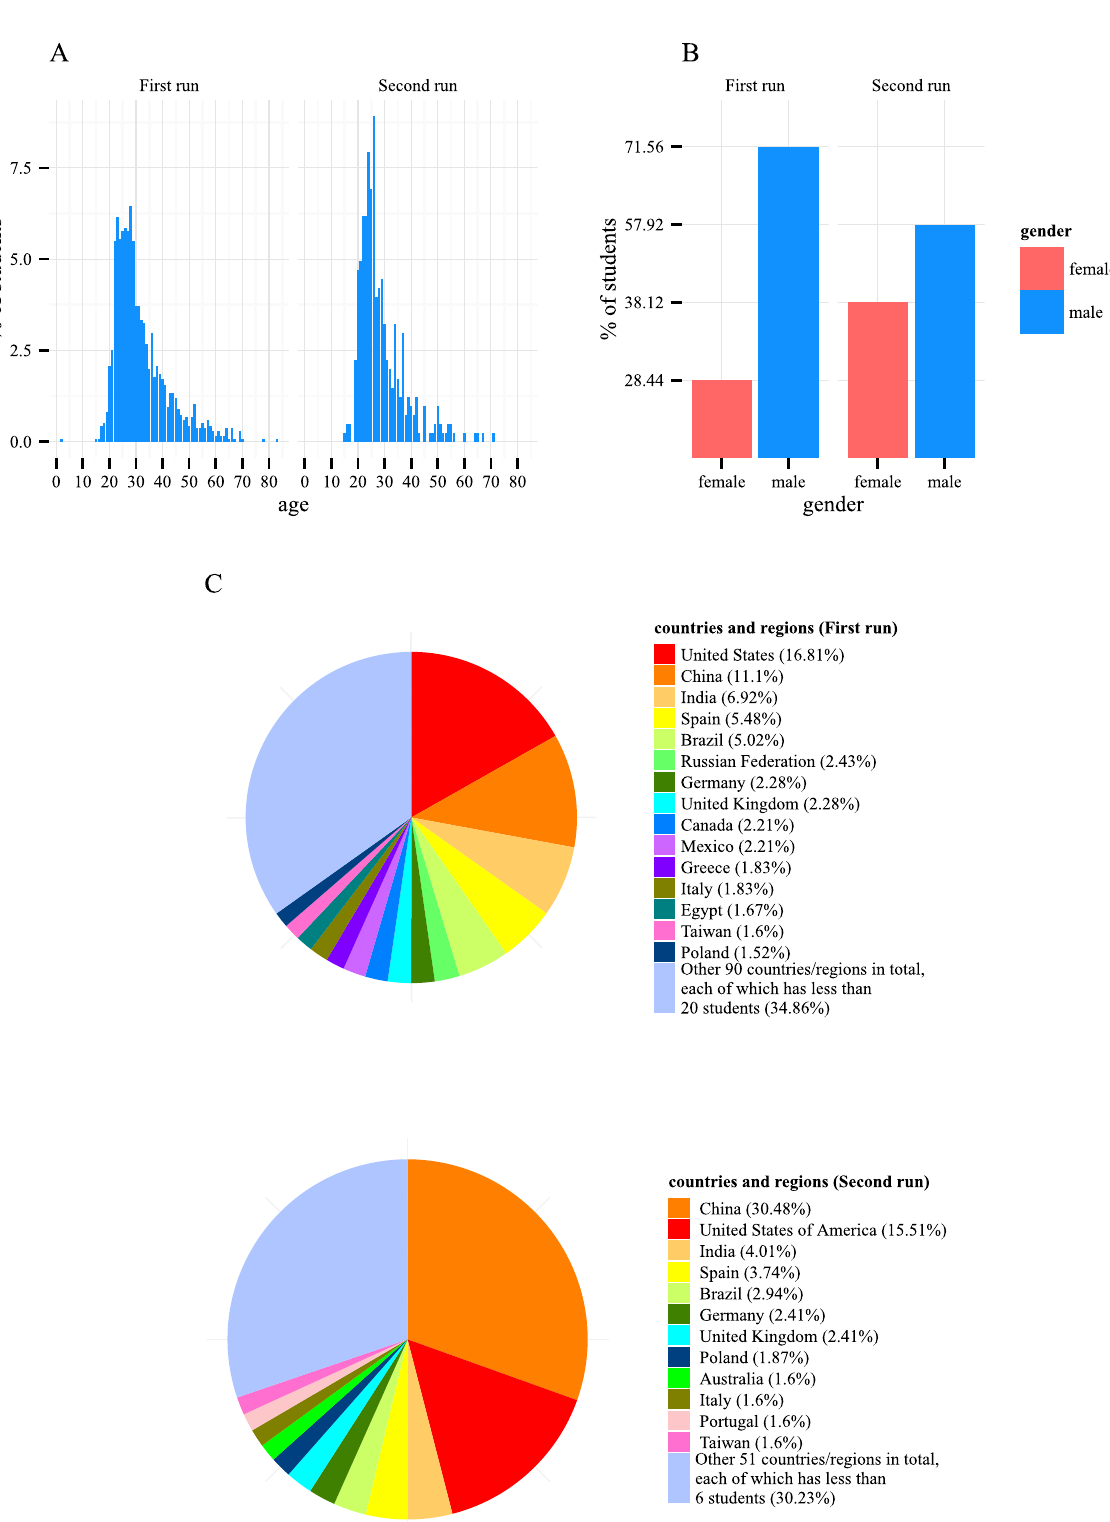
Figure 2. Students’ demographic profiles were diverse. (A) The most prevalent age group consisted of students in their twenties. (B) There were more male students than female students. (C) Students came from over 100 countries and regions.